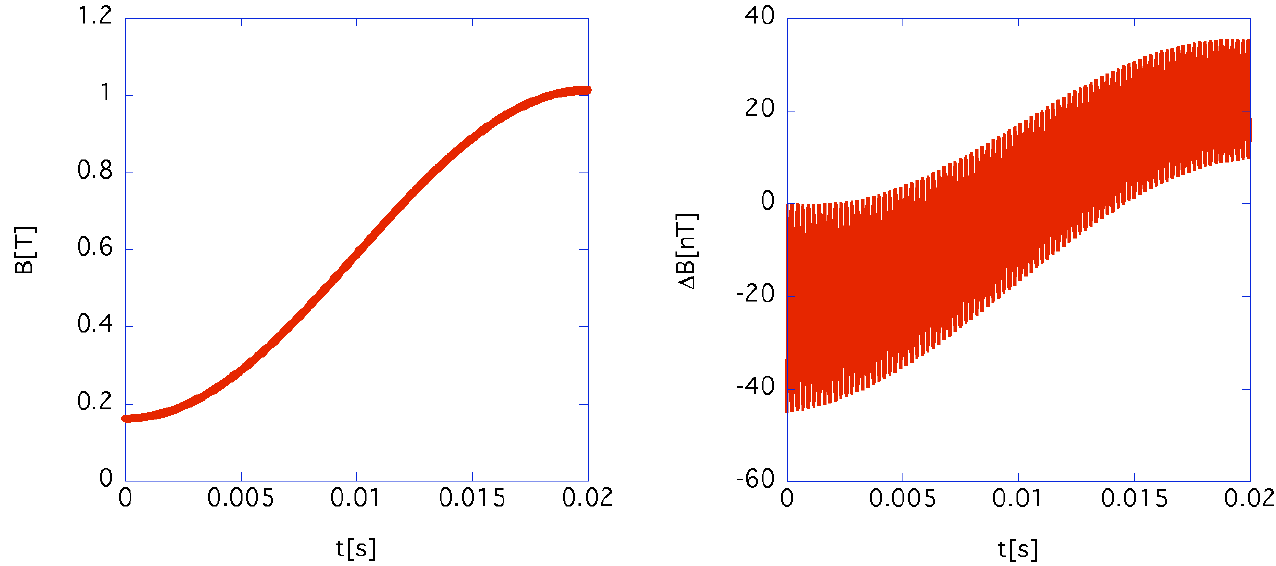
FIG. 31. (Color) The time dependence of the original bending magnet B ð t Þ is given in the left figure (analytical data) and the modulation of it (theoretical results) is in the right figure. The field modulation inside the chamber is insignificant. The same parameters as in Fig. 24 are used. Namely, the length of the chamber l is 80 cm, the radius of chamber a is 15.25 cm, the total number of Cu stripes N is 100, the attached capacitance C for each stripe is 0 : 3 (cid:5) F . The chamber is surrounded by the ferromagnetic yoke whose longitudinal length is 80 cm, gap height 2 g ¼ 32 : 0 cm , and gap width 2 h ¼ 32 : 0 cm . As a typical set of parameters, ramping time T ¼ 20 ms , the radius of curvature (cid:9) ¼ 12 : 578 m , the injection momentum p ¼ 3 : 8 GeV =c p fin